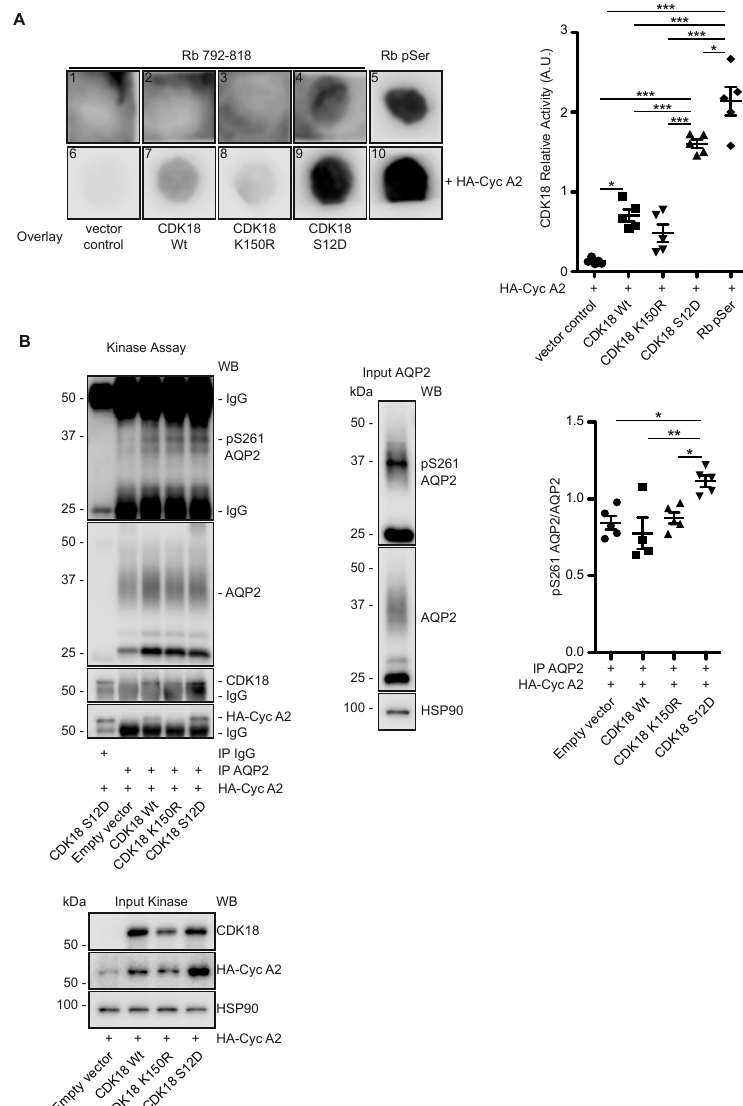
Figure 3. CDK18 phosphorylates AQP2 at S261. CDK18 in its wild type (Wt), kinase dead (K150R) or constitutively active form (S12D) and the co-activator Cyclin A2 (Cyc A2) were obtained by precipitation with anti-FLAG beads from HEK293 cells overexpressing the proteins. ( A ) Activity of the purified CDK18 versions was assayed using spot-synthesized peptides representing amino acids 792–818 of human retinoblastoma protein (Rb) CDK18 substrate. As a control, the peptides were spot-synthesized prephosphorylated at position S795, S807 and S811 (Rb pSer). Phosphorylated Rb was detected using an anti-phospho-CDK / MAPK substrate antibody. Due to the low signals from spots 1–5, only spots 6–10 were analyzed by densitometry; n = 5. ( B ) Left panel: AQP2 was immunoprecipitated (IP) from MDC4 cells. As control, immunoprecipitation was carried out with control IgG (IgG). The